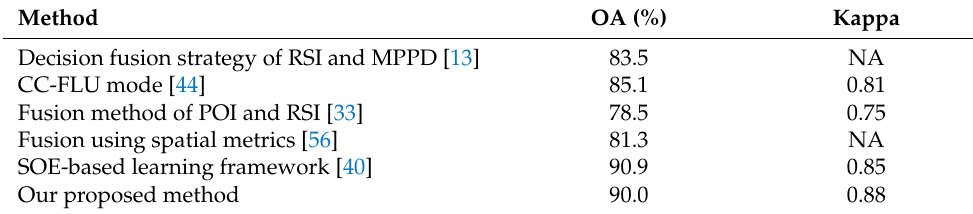
Table 8. Overall accuracy of the proposed method compared with other fusion methods. Method OA (%) Kappa Decision fusion strategy of RSI and MPPD